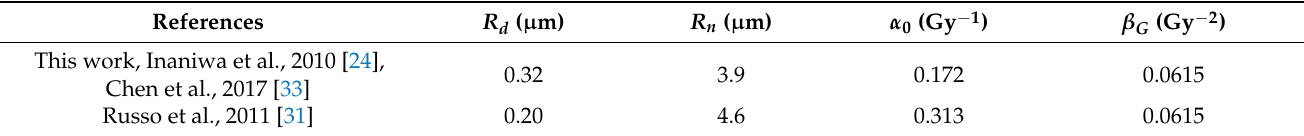
Table 2. mMKM input parameters for the HSG cell line from various